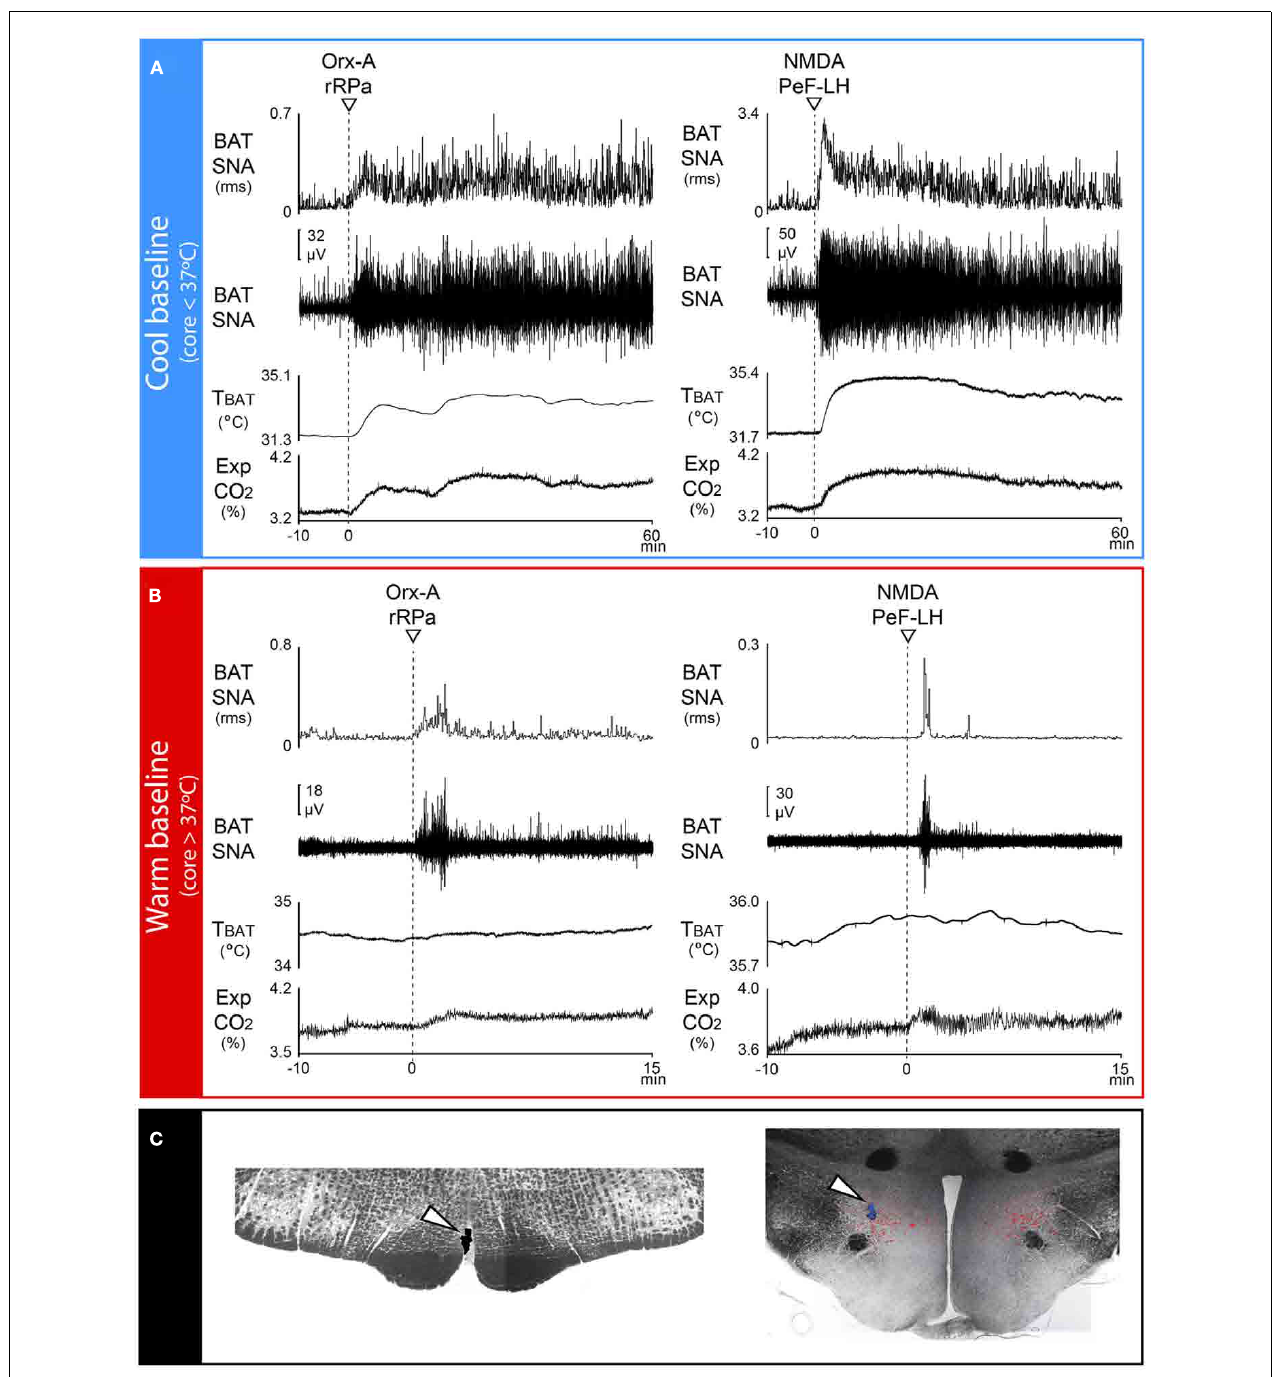
> 37˚C) in which no basal BAT SNA was present, nanoinjections of Orx-A (left panel, dashed line) in rRPa or of NMDA (right panel, dashed line) into the PeF-LH failed to evoke significant changes in BAT SNA,TBAT or Exp CO 2 . (C) Representative histological sections illustrating nanoinjection sites in the rRPa (left panel, white arrowhead) and in the PeF-LH (right panel, white arrowhead). Note that the NMDA injection sites in the PeF-LH were located in the midst of many neurons immunohistochemically labeled for Orexin-A (red). Modified with permission fromTupone et al.